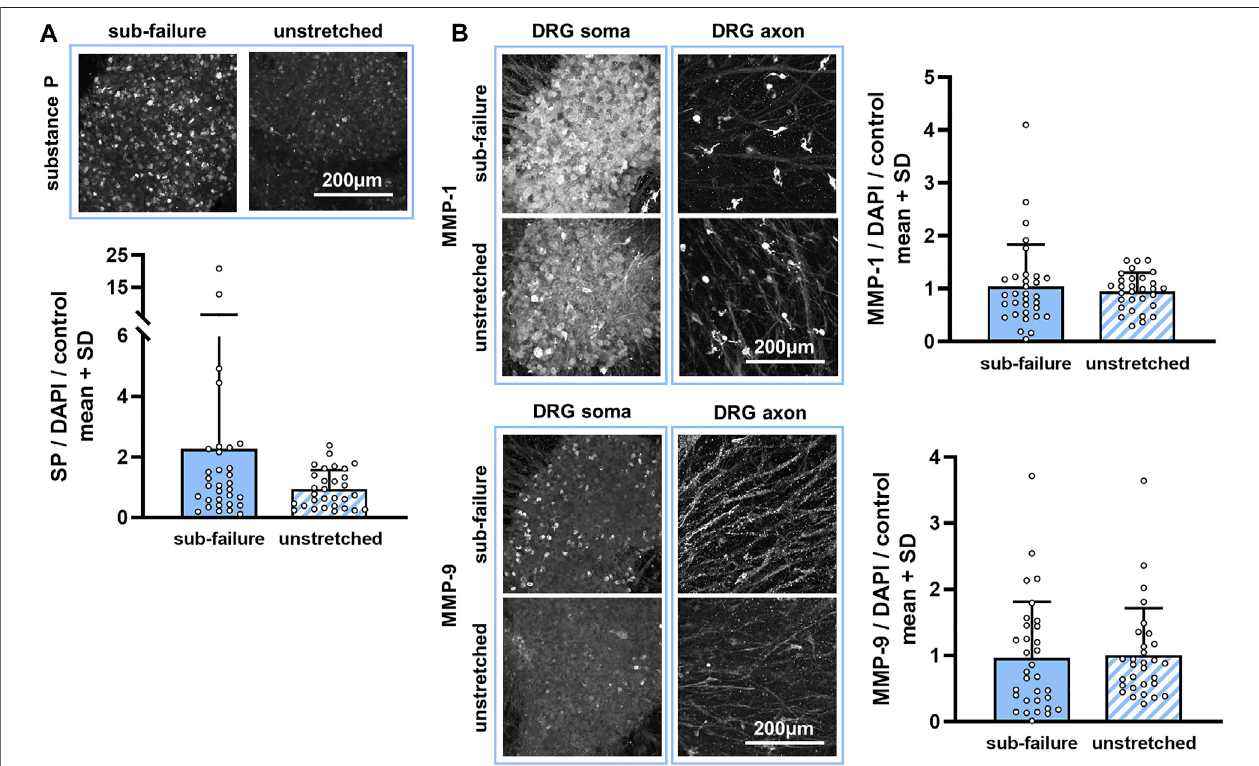
FIGURE 4 | Sub-failure stretch alters substance P, but not statistically signi fi cantly, and does not change MMP expression. (A) Substance P labeling is primarily evident in neuronal cell bodies (soma) and increases to 2.20 ± 3.96-fold over unstretched controls ( p = 0.404; MANOVA, n = 6/stretch condition). (B) Abundant MMP-1 and MMP-9 labeling is observed in the DRG soma and in cells surrounding the DRG axons in co-culture gels. Expression levels of MMP-1 and MMP-9 ( p = 0.404; MANOVA, n = 6/stretch condition) do not differ between sub-failure stretch and unstretched gels. Superimposed data points represent quanti fi cation in each confocal image acquired ( n = 6/gel). The scale bar in each protein panel applies to all images in that